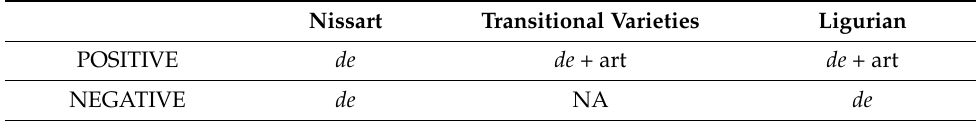
Table 9. Marking of plural indefinite and singular mass